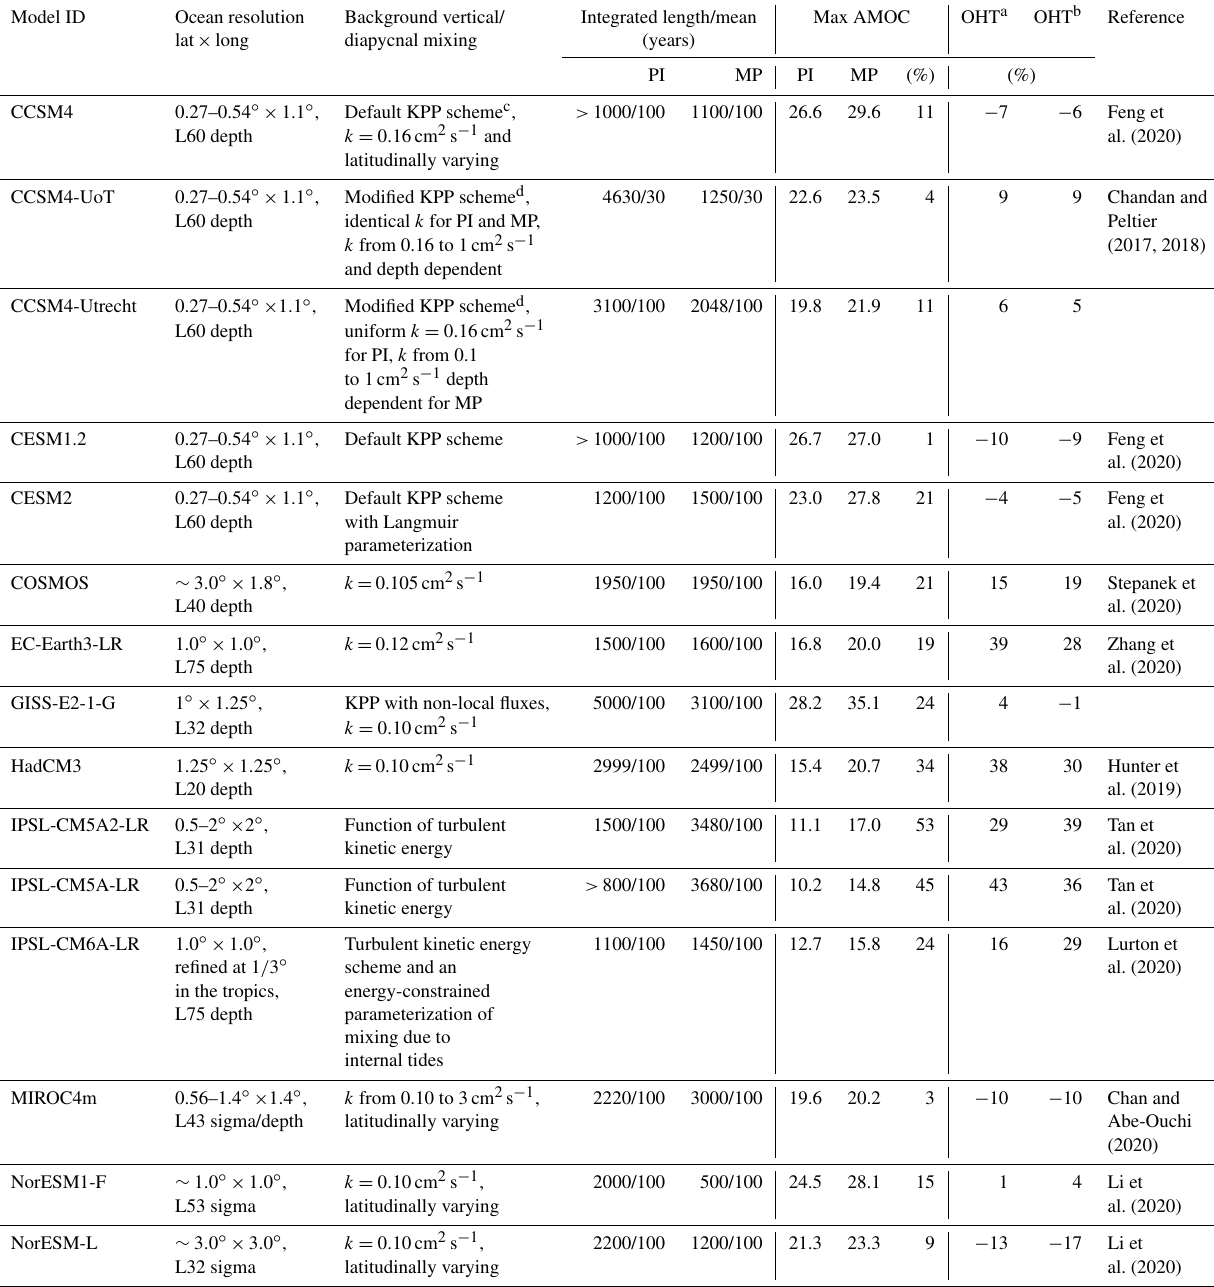
Table 1. Comparison of PlioMIP2 models. “PI” denotes pre-industrial, “MP” denotes mid-Pliocene and “OHT” denotes ocean heat transport. Model